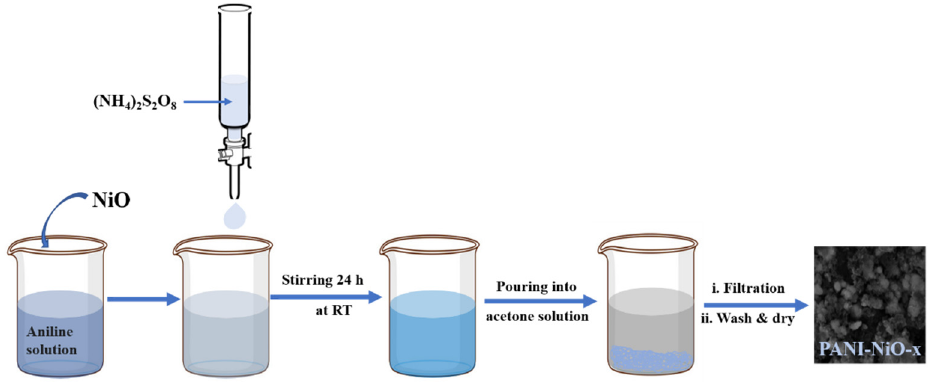
Figure 1. Schematic representation of the preparation of the PANI-NiO-x nanocomposites .